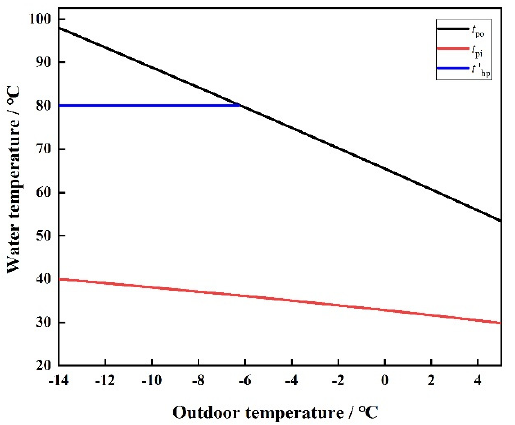
Figure 3. The temperatures of the supply water and return water vs. the outdoor temperature.